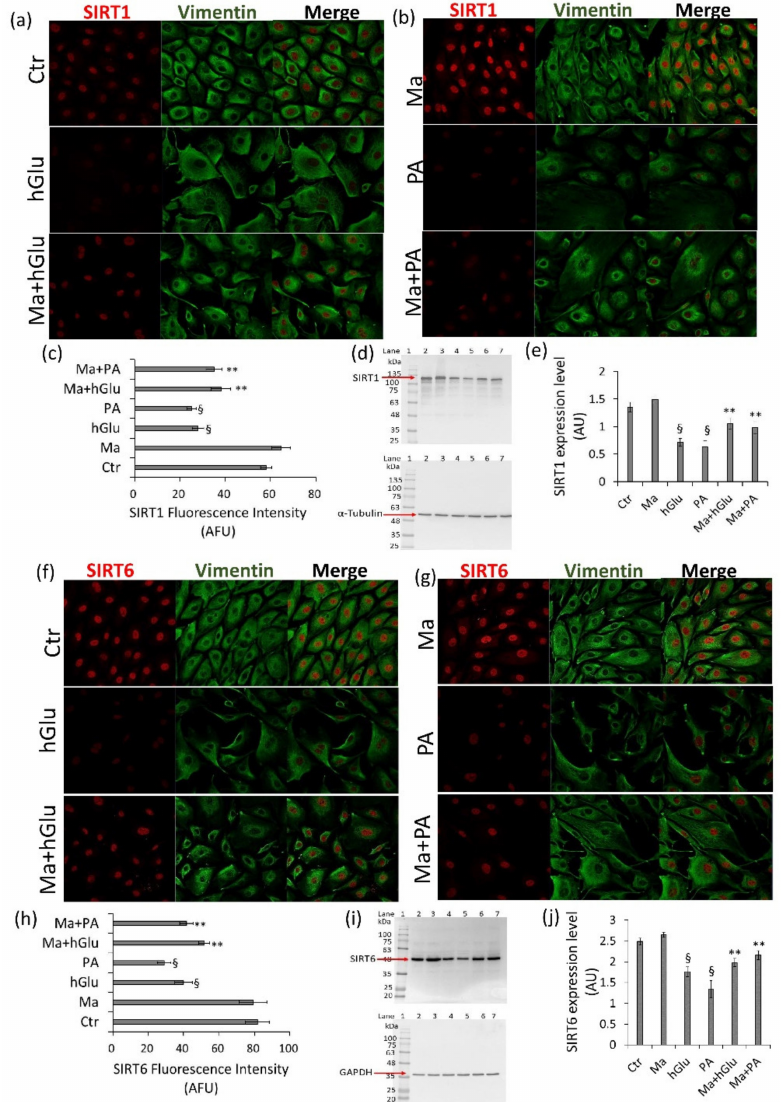
Figure 4. SIRT1 and SIRT6 activation by Magliocco. ( a , b ) Representative confocal images of SIRT1 (red) and vimentin (green) and ( c ) fluorescence intensity determination performed by ImageJ software and expressed as arbitrary fluorescence units (AFU) ± SD of n = 3 replicates. ( d , e ) Western blot analysis of SIRT1 expression levels. ( f , g ) Representative confocal images of SIRT6 (red) and vimentin (green). ( h ) Fluorescence intensity analysis. ( i , j ) Western blot analysis of the SIRT6 expression levels. Lane 1 = protein ladder molecular weight markers, lane 2 = Ctr, lane 3 = Ma, lane 4 = hGlu, lane 5 = PA, lane 6 = Ma+hGlu, and lane 7 = Ma+PA. The analysis of densitometric intensity was calculated with ImageJ software and expressed as arbitrary units (AU) ± SD of n = 4 replicates. α -Tubulin or GAPDH was used as the internal control. § p < 0.01 vs. Ctr, ** p < 0.01 vs. hGlu and vs.